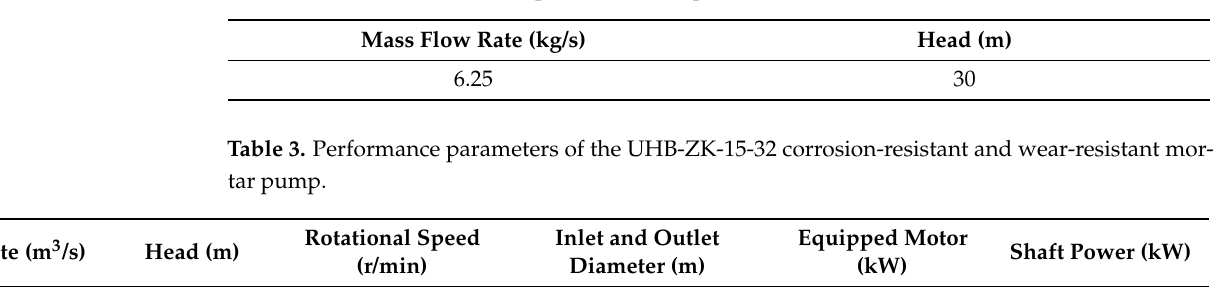
Table 3. Performance parameters of the UHB-ZK-15-32 corrosion-resistant and wear-resistant mor- tar pump. Table 2. Flow rate and head required for the experiment.